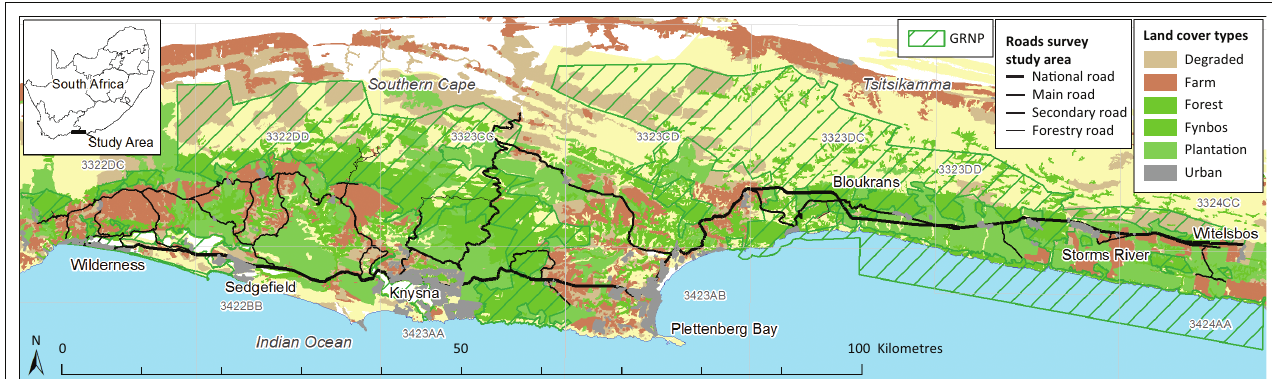
FIGURE 1: The study area showing the Garden Route National Park, the Southern Cape and Tsitsikamma regions, the roads surveyed and the land cover types adjacent to